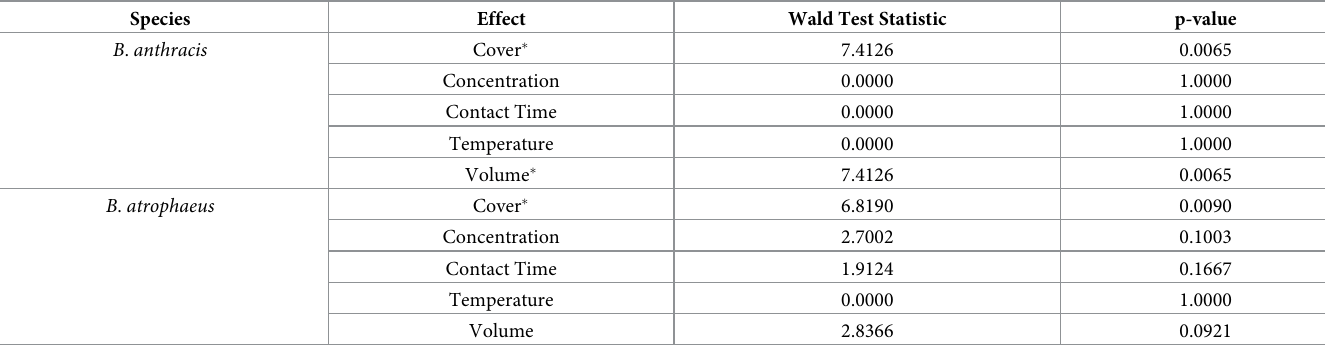
Table 4. Statistical analysis of ability to achieve complete inactivation, by species.